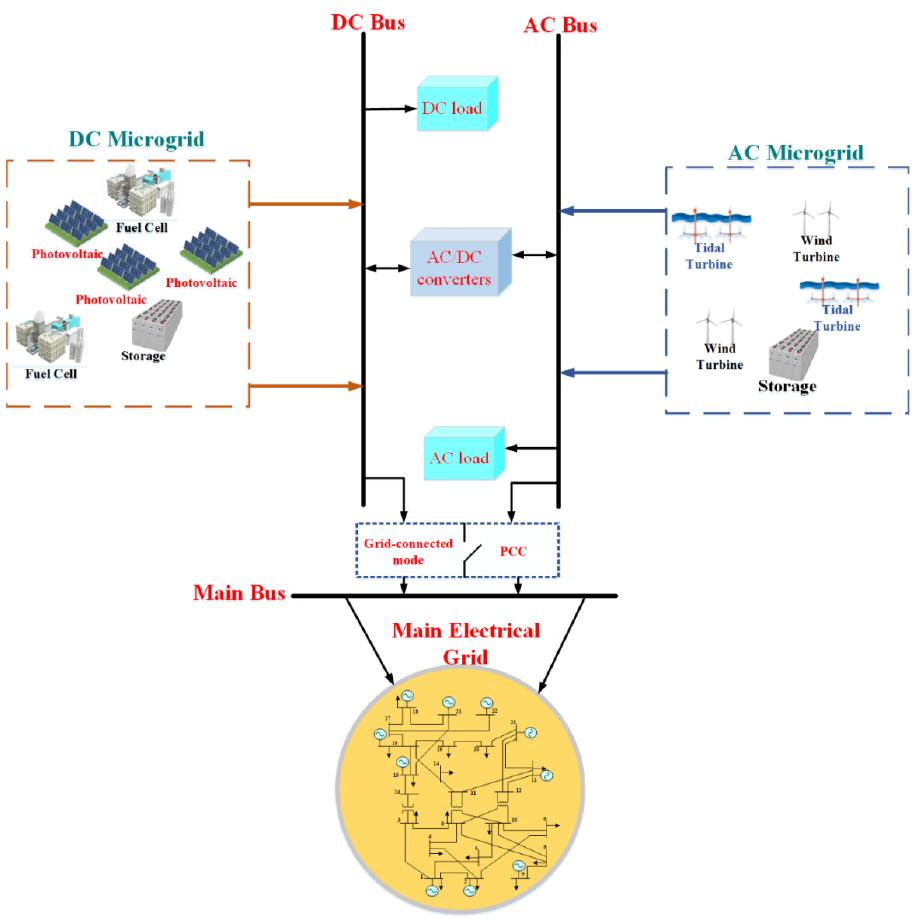
Figure 1. The proposed hybrid energy framework.